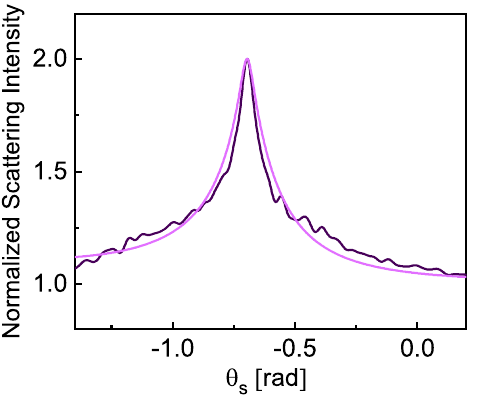
Figure 5. Numerically calculated normalized ensemble-averaged scattering intensity for N p = 10, 000 , L = 20 (cid:31) 0 , and ρ = 0.021 for N r = 10, 000 (dark curve) and theoretical fit (Eq. 3) with l e used as fitting parameter (light color). Note that l e value is normalized to the free-space wavelength.